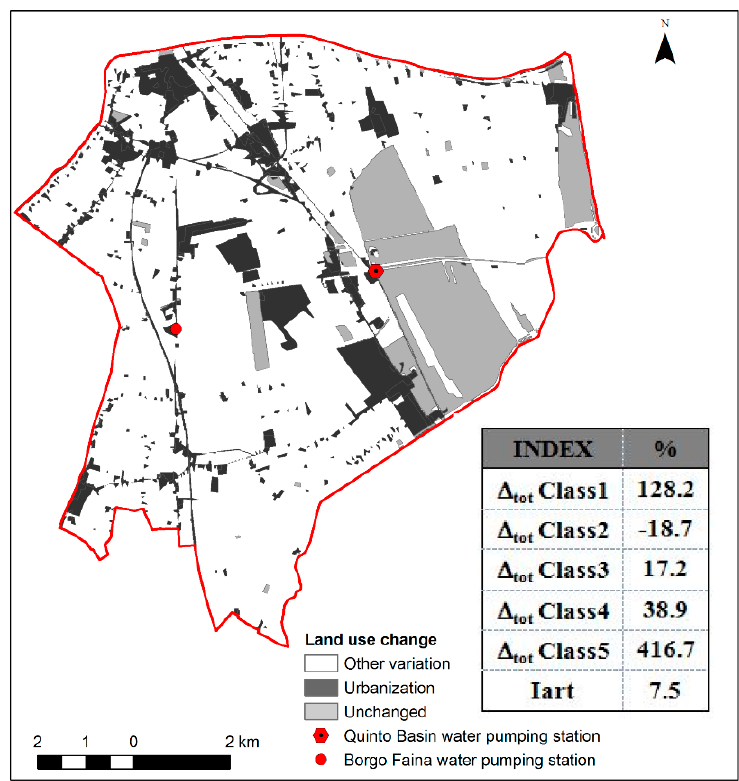
Figure 8. Map of land use change 1976–2014. In the legend: ‘urbanization’ means the expansion of urban areas on land once occupied by crops, pastures, and other classes; ‘unchanged’ includes all areas where the main land use remained the same over the period; ‘other variations’ includes all evolutions different from the urbanization, such as reforestation, deforestation, and changes to agricultural areas. The artificialization index (Iart) and the total change of the five Corine Land Cover macro-classes are reported in the Table on the map: class 1 is for urbanized areas, productive and commercial settlement, public and private services, industrial zones, infrastructure areas, etc.; class 2 refers to agricultural areas; class 3 is for forests and semi-natural environments; class 4 is for wetlands; and class 5 is for the water bodies both for continental and marine waters. Table 1. Correlation coefficients between rainfall and drainage at different lag time (in days) for the period of minimum (1971–1981) and maximum urbanization (2006–2016).